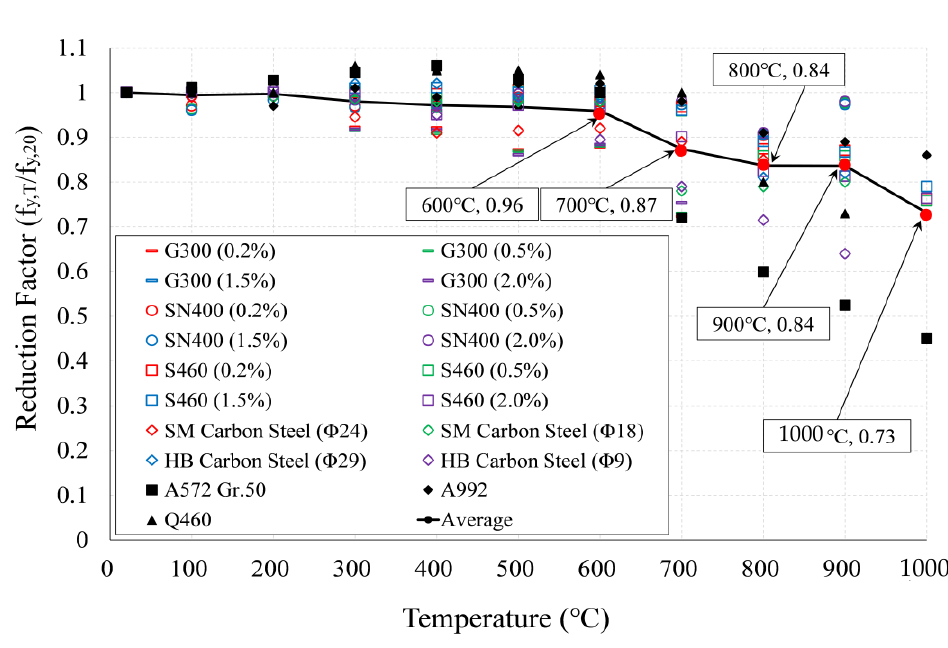
Figure 3. Comparison of reduction factor CIA test. Table 2. Reduction factor of mild steel after the fire.